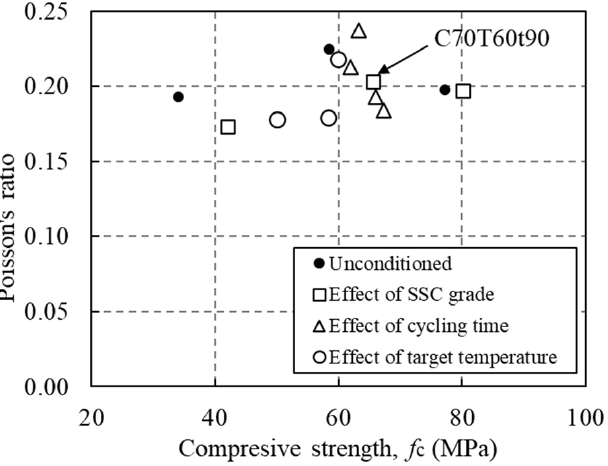
Figure 10. Relationship between Poisson’s ratio and compressive strength.